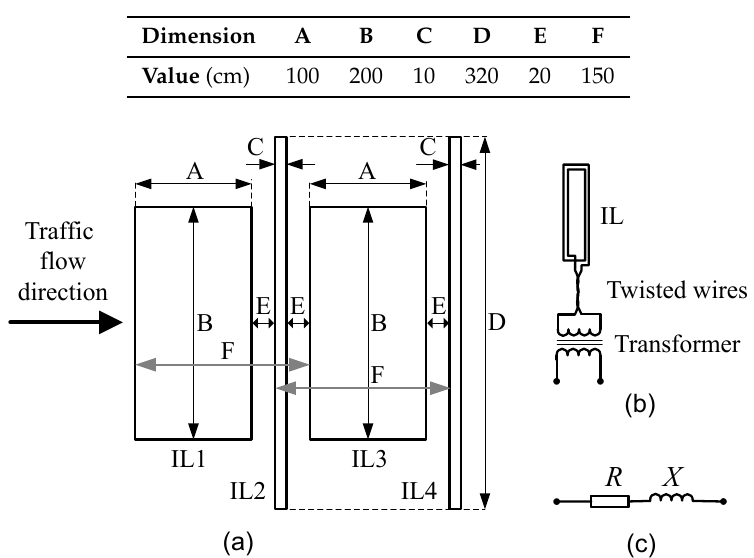
Table 1. Loops dimensions.